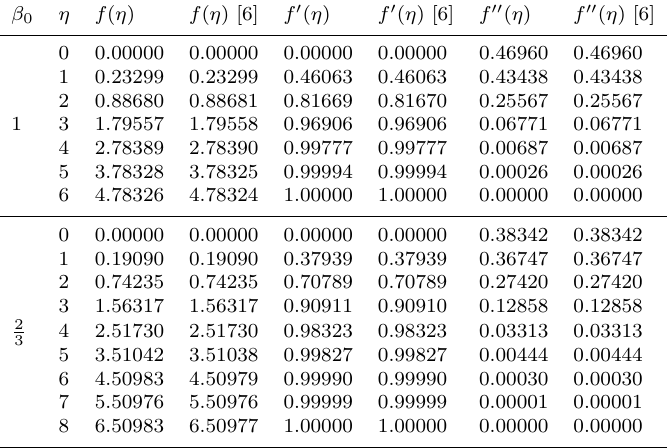
Table 2. Numerical solution of Blasius equation with β 1 =0 compared to Cortell’s [6] solution.